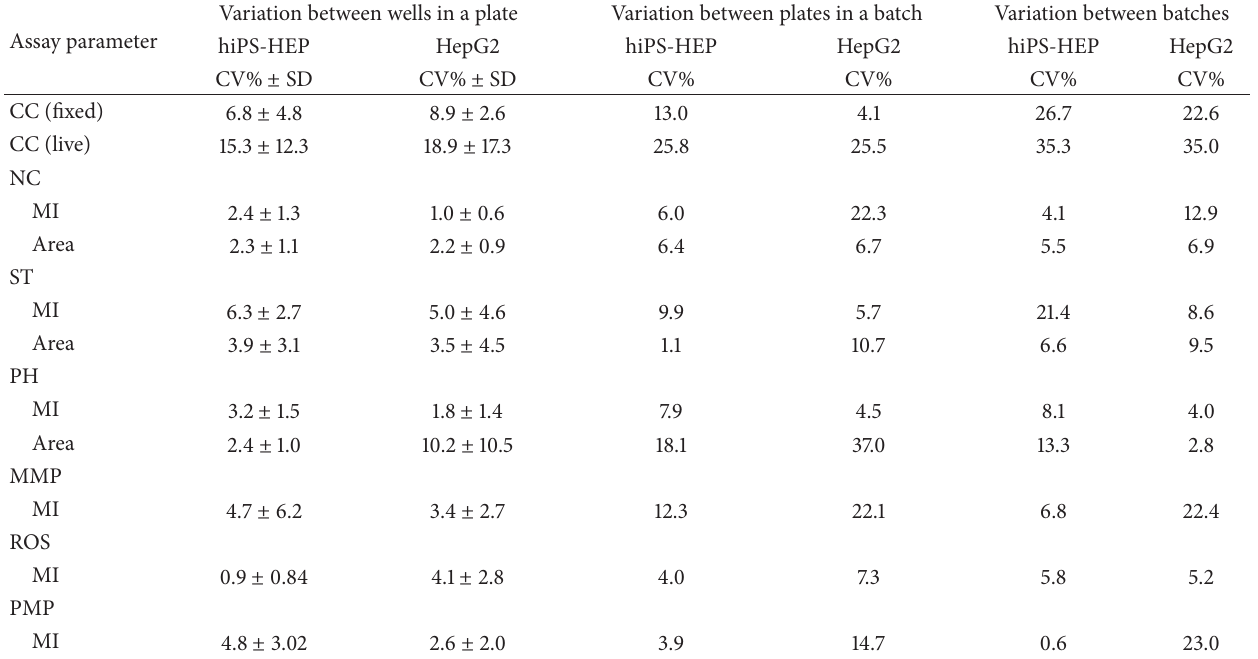
Table 5: Comparison of assay imprecision for each parameter measured in hiPSC derived hepatocytes (hiPS-HEP) and HepG2. Variation between wells in a plate Variation between plates in a batch Variation between batches Assay parameter hiPS-HEP HepG2 hiPS-HEP HepG2 hiPS-HEP